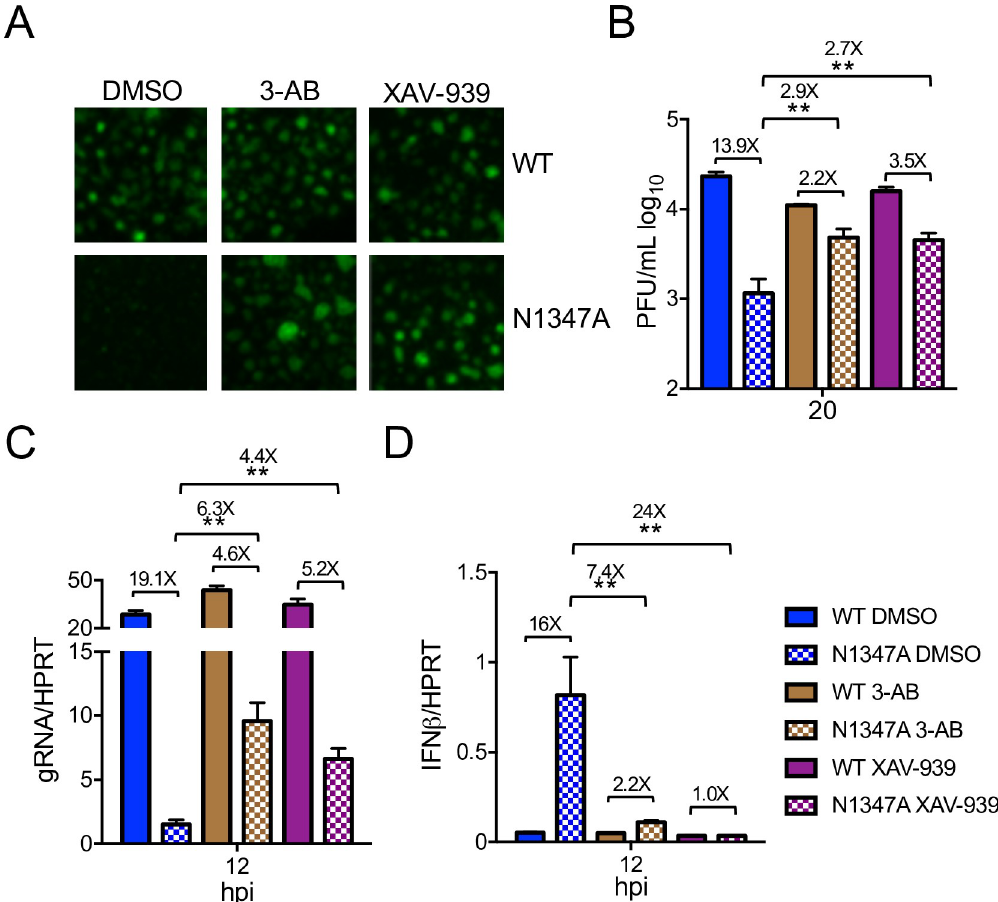
Fig 4. PARP catalytic activity is required for inhibition of replication and enhanced IFN production during N1347A MHV infection. (A-D) BMDMs were infected with WT or N1347A MHV and treated with vehicle (0.25% DMSO), 5 mM 3-AB, or 10 μ M XAV-939 following a 1-hour adsorption phase. Cells were either fixed at 16 hpi and analyzed for virus- encoded GFP expression by fluorescence microscopy (A); collected at 20 hpi, and viral titers determined by plaque assay (B); or collected at 12 hpi, and RNA levels determined by RT-qPCR with primers specific to genomic RNA (C) or IFN β (D). The data in (A-D) show one experiment representative of two independent experiments; DMSO, n = 6; 3-AB and XAV-939, n = 3. Numbers above bars represent fold difference between WT and N1347A or between DMSO- and inhibitor-treated cells infected with N1347A virus.